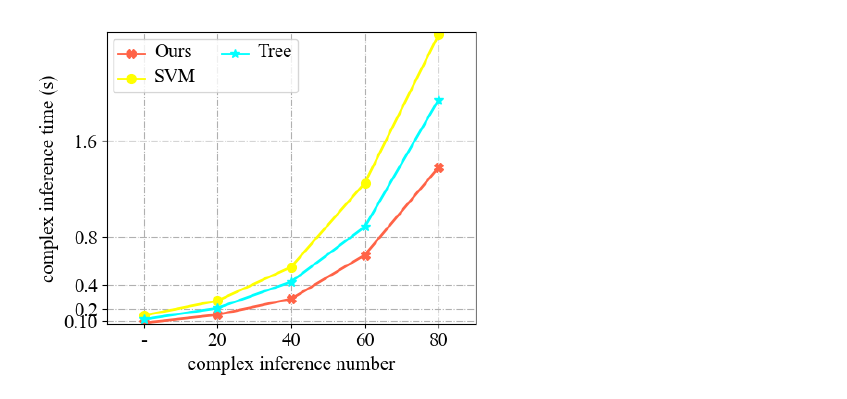
Figure 6. A line chart of the inference speed of three other models in the case of complex and different inference